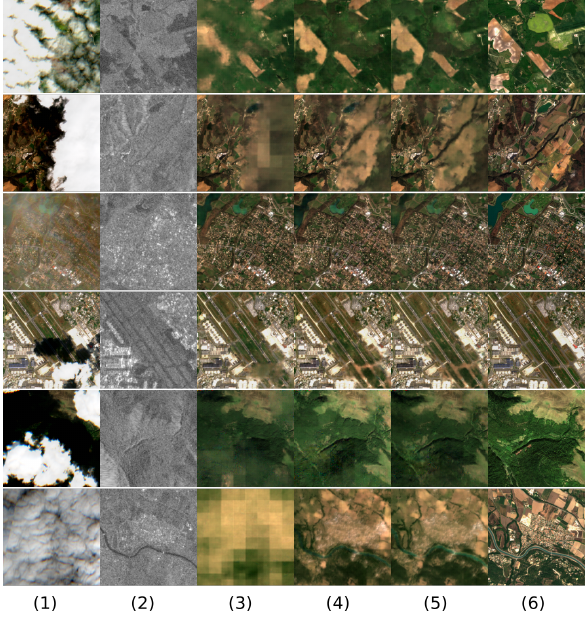
Figure 9. From left to right: input cloudy optical image S 2 t (1), input SAR image S 1 t (2), output (cid:100) S 2 t from SSOP unet,w/oSAR (3), SSOP unet (4), and SSOP unet + DEM (5), (6) reference